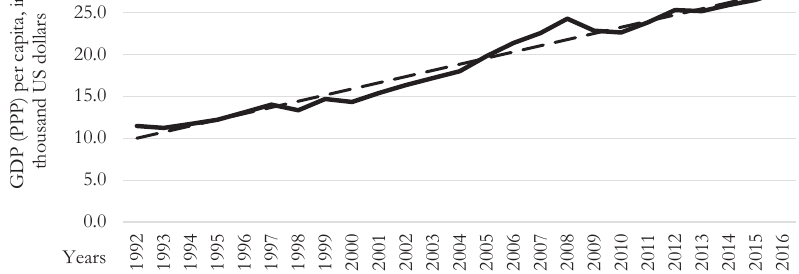
Fig. 11 – Dynamics of GDP (PPP) per capita of the median level for countries worldwide. Source: own calculations